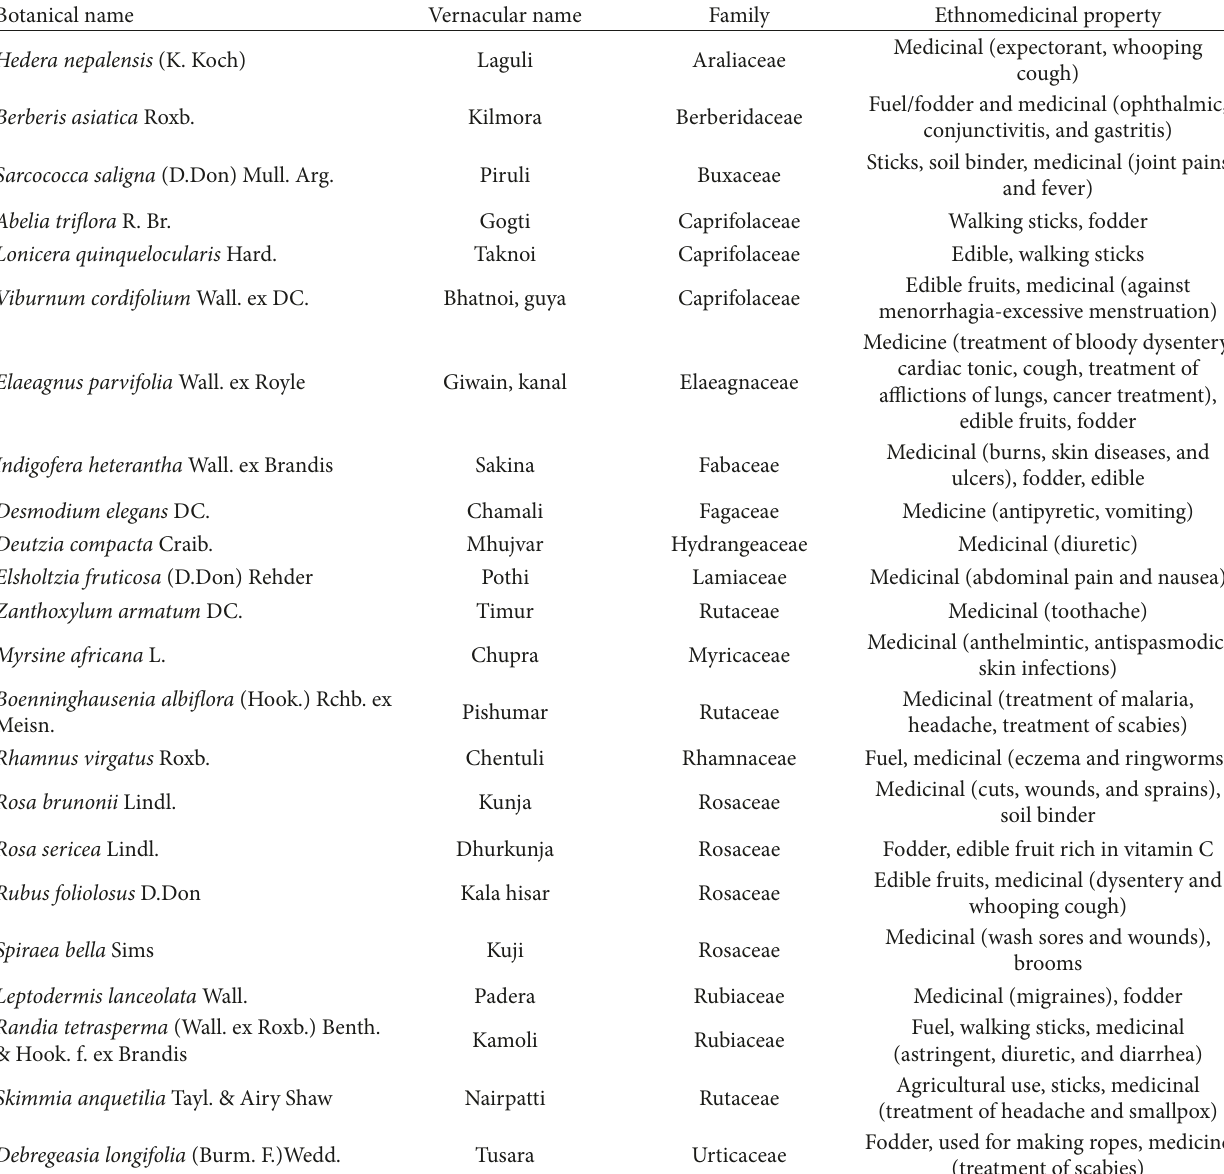
Table 3: List of Shrub species (with ethnomedicinal properties) found in Hariyali Devi